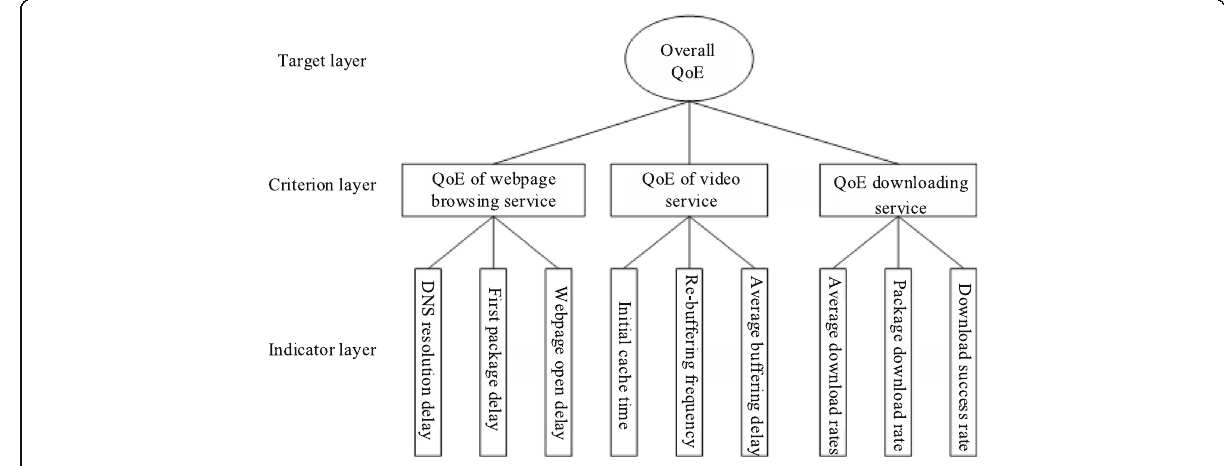
Fig. 6 QoE evaluation model in our